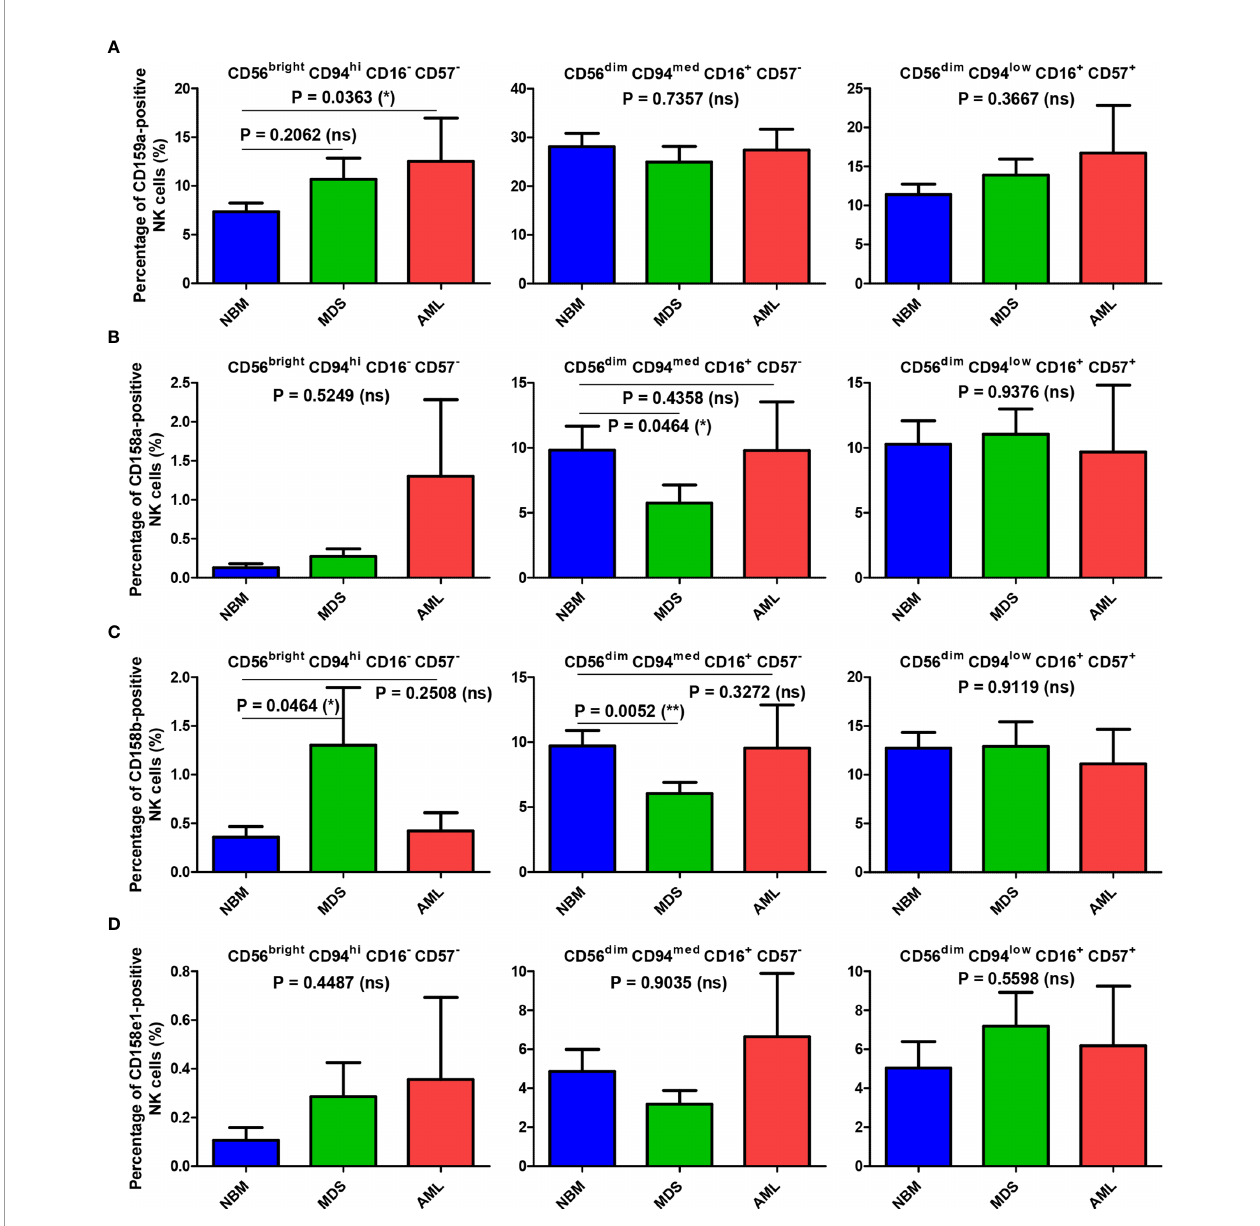
FIGURE 5 | Comparison of the mean percentages of NK subsets expressing CD159a and KIR receptors within the bone marrow microenvironment of NBM, MDS, and AML cases. (A – D) Left panel: CD56 bright CD94 hi CD16 - CD57 - immature NK subset; middle panel: CD56 dim CD94 med CD16 + CD57 - mature NK subset; right panel: CD56 dim CD94 low CD16 + CD57 + hypermature NK subset; (A) Percentage of bone marrow CD159a-positive NK subsets in normal bone marrow (NBM, n = 30), myelodysplastic syndromes (MDS, n = 25), and acute myeloid leukemias (AML, n = 8) cases. Bars represent the mean ± SEM (*P < 0.05, ns, not signi fi cant; one-way ANOVA test followed by Tukey ’ s Multiple Comparison test; only for comparing immature NK subsets of NBM vs. MDS: Mann Whitney test). (B) Percentage of bone marrow CD158a-positive NK subsets in NBM (n = 30), MDS (n = 24), and AML (n = 8) cases. Bars represent the mean ± SEM (*P < 0.05, ns, not signi fi cant; one-tailed Mann Whitney and Kruskal-Wallis followed by Dunn ’ s Multiple Comparison tests for immature and mature NK subsets, one-way ANOVA followed by Tukey ’ s Multiple Comparison test for hypermature NK subsets). (C) Percentage of bone marrow CD158b-positive NK subsets in NBM (n = 30), MDS (n = 25), and AML (n = 8) cases. Bars represent the mean ± SEM (**P < 0.01, *P < 0.05, ns, not signi fi cant; Mann Whitney and Kruskal-Wallis followed by Dunn ’ s Multiple Comparison tests for immature and mature NK subsets, one-way ANOVA followed by Tukey ’ s Multiple Comparison test for hypermature NK subsets). (D) Percentage of bone marrow CD158e1-positive NK subsets in NBM (n = 30), MDS (n = 25), and AML (n = 8) cases. Bars represent the mean ± SEM (*P < 0.05, ns, not signi fi cant; Kruskal-Wallis followed by Dunn ’ s Multiple Comparison